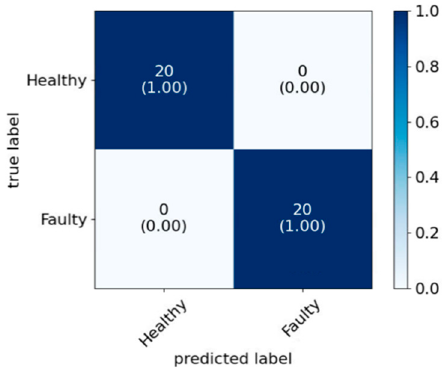
Figure 9. Model 2—confusion matrix for engine misfire data.